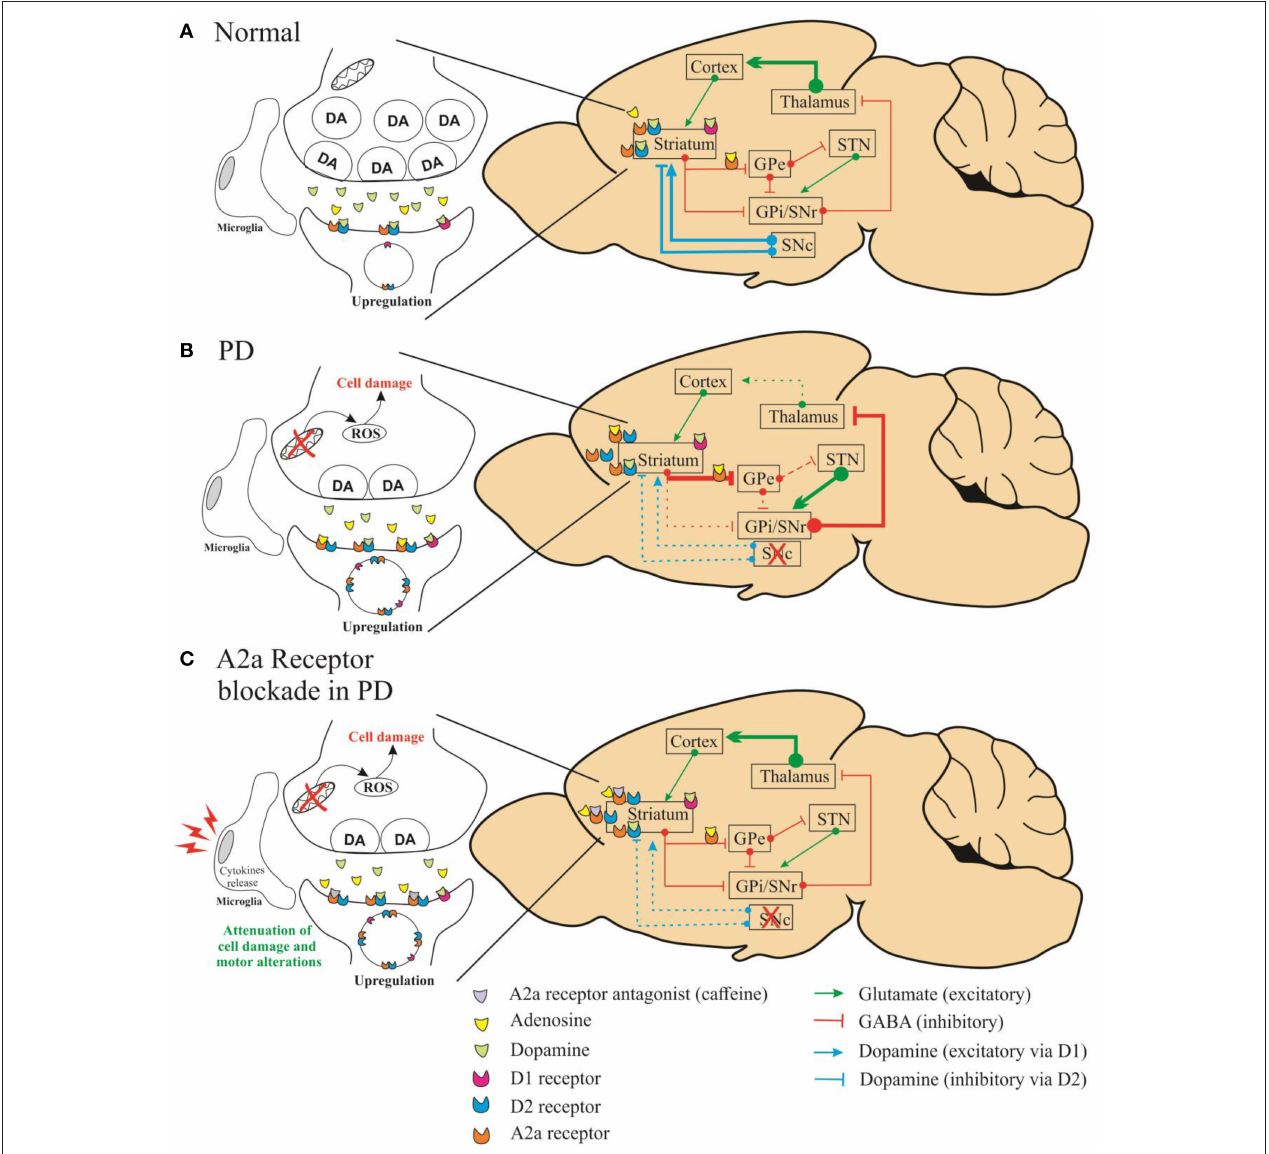
FIGURE 1 | Schematic representation of simplified diagram demonstrating the connections within the basal circuitry, and changes in the activity of basal ganglia nuclei associated with the mechanism of symptomatic anti-Parkinsonian activity of A2A receptor antagonists. The striatum is connected to the thalamus through two pathways: indirect (striatum/globus pallidus pars externa-GPe/subthalamic-STN/nigral) and direct (globus pallidus pars interna complex-GPi/substantia nigra pars reticulate-SNr) pathways. In the normal state (A) , dopamine of the substantia nigra pars compacta (SNc) acts on inhibitory D2 receptors of the indirect pathway and on stimulatory D1 receptors of the direct pathway. In (B) , altered pathways are seen in Parkinson’s disease caused by depletion of dopamine. In (C) , the A2A receptors modulate the indirect basal ganglia pathway due the co-localization with the dopaminergic D2 receptors